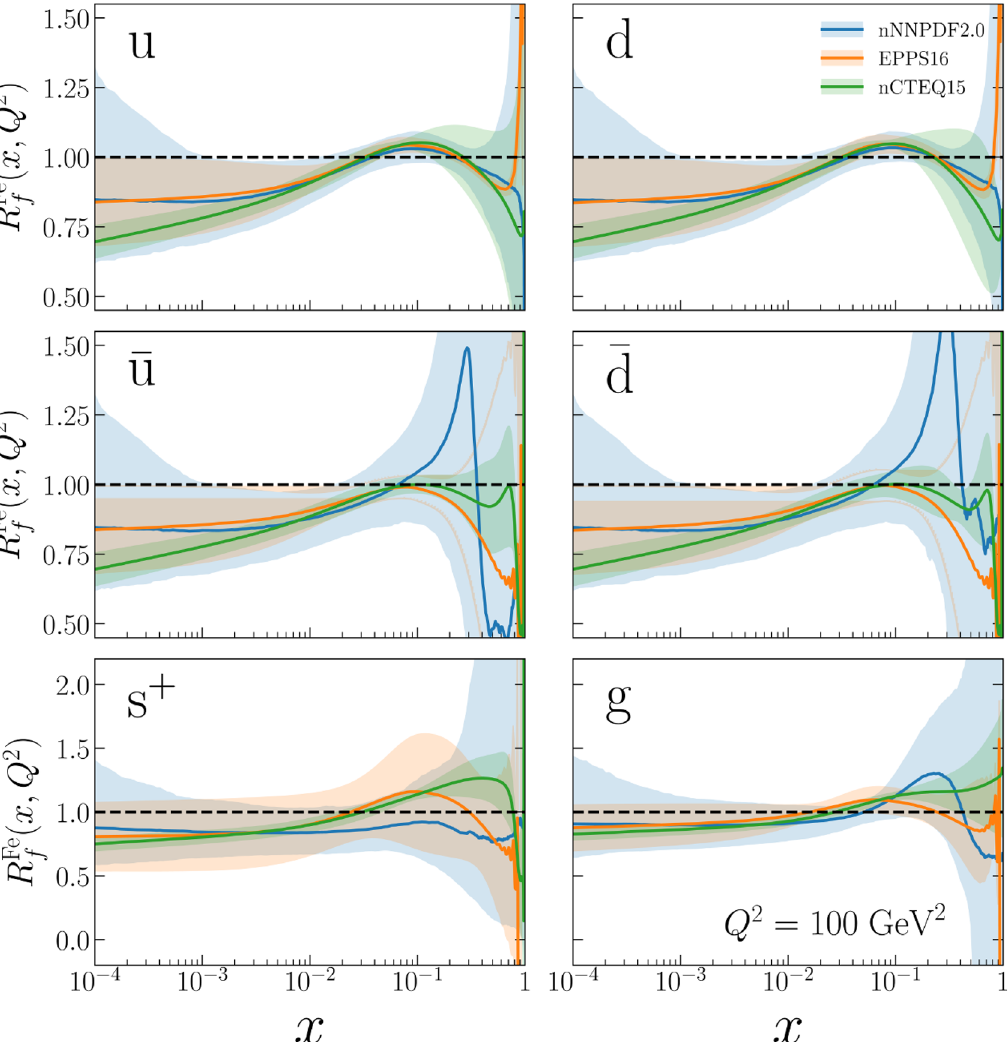
Figure 13 . The nuclear PDF modi(cid:12)cation ratios for iron, R Fe ( x; Q 2 ), as a function of x at Q = 10 GeV for nNNPDF2.0, EPPS16, and nCTEQ15. From top to bottom we show the up and down quarks, the corresponding antiquarks, the total strangeness, and the gluon. The bands correspond to the 90% CL uncertainties, and each nPDF set is normalised to its corresponding free-proton baseline as indicated by eq.